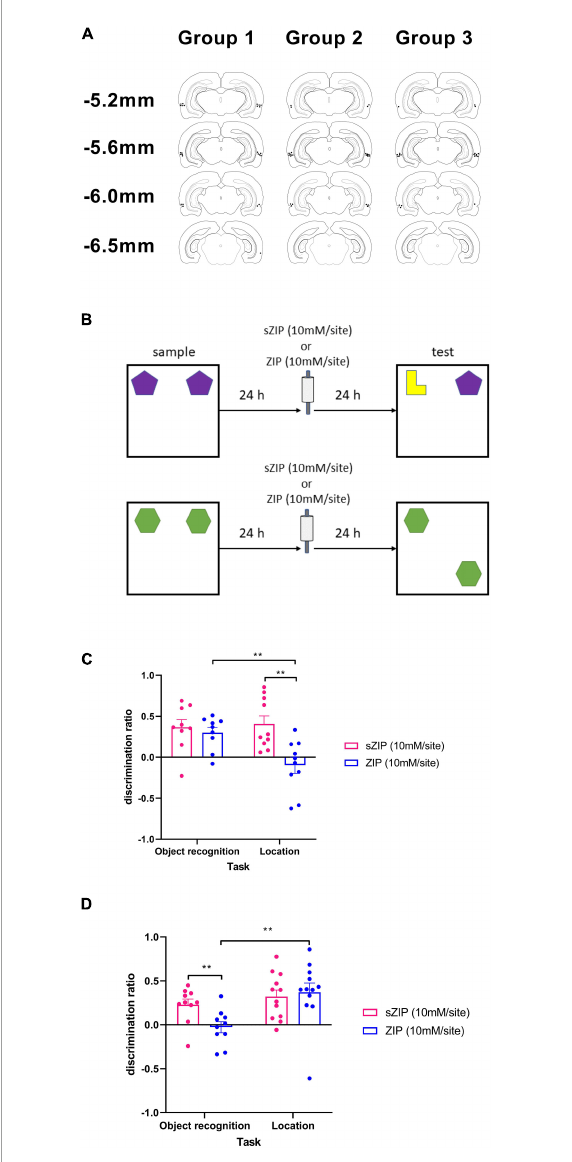
FIGURE1 Infusion of ZIP into PRH impaired the maintenance of object recognition but not object location memory. (A) Location of cannulae tips targeting PRH in the three groups of animals used in this study. (B) Outline of novel object recognition and object location tasks used, ZIP was infused 24 h after the sample phase and 24 h before the test phase. (C) Performance in the object location but not the object recognition task was significantly impaired following infusion of ZIP into the HPC. (D) Performance in the object recognition task but not the object location task was significantly impaired following infusion of ZIP into PRH. Data presented as mean + sem, ** p < 0.01, HPC: NOR n = 9, OL n = 10, PRH: NOR n = 10, OL n = 12.